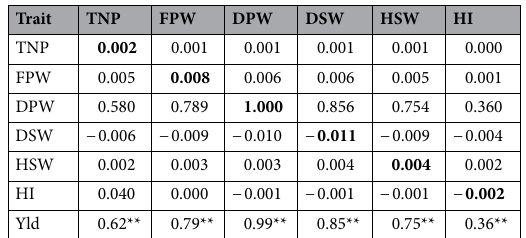
Table 10. Second-order components’ effects on yield. TNP = total number of pods, FWP = fresh pods weight (g), DPW = dry pods weight (g), DSW = dry seeds weight (g), HSW = hundred seed weight (g), HI = harvest index, and YLD = yield